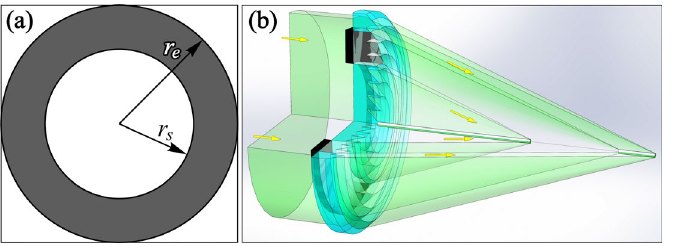
Figure 3. Illustration of the formation of an optical bottle due to radiation blocking by an annular screen: ( a ) view of the annular slot and ( b ) geometric-optical visualization of the formation of an optical bottle on the optical axis.